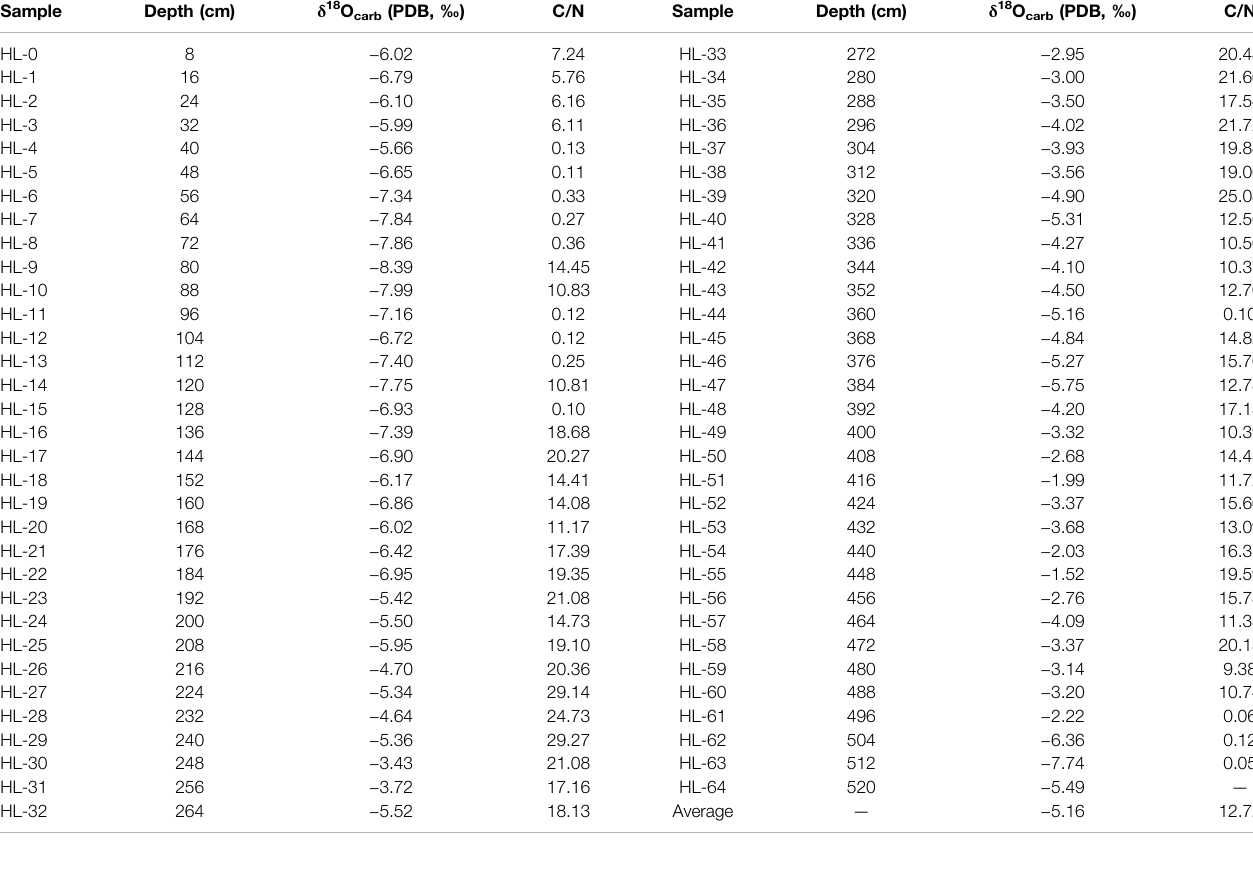
TABLE 3 | δ 18 O carb of fi ne-grain carbonate and C/N ratios of the HL18-3 core. Sample Depth (cm)